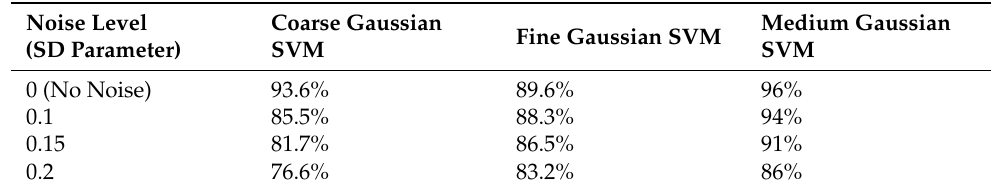
Figure 12. Confusion matrix of motor bearing failure prediction in medium Gaussian SVM on the noisy environment, with a total accuracy of 94%. Table 3. The noise level affects the comparison of the accuracy of the three SVM